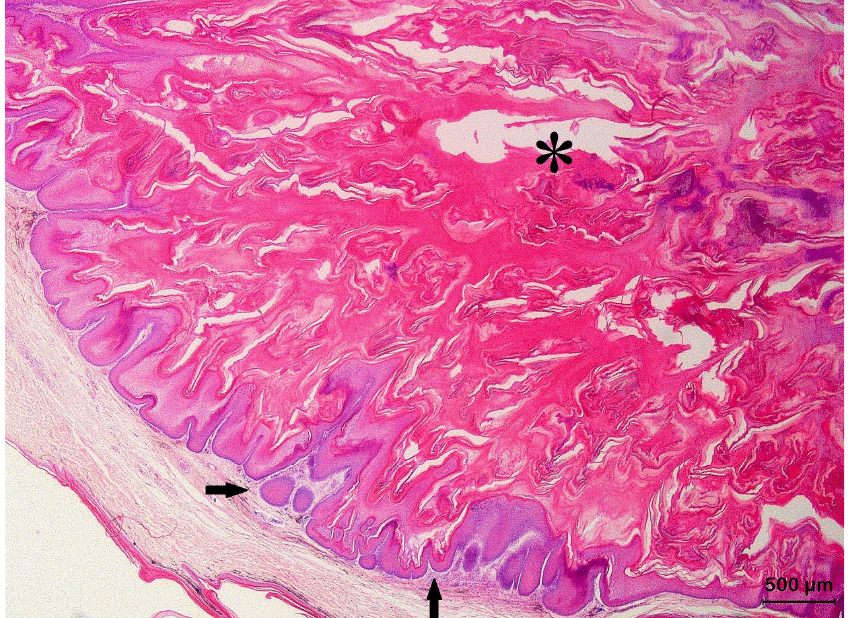
Figure 4. Histological section of a keratoacanthoma from the skin of the body wall of a bearded dragon ( Pogona vitticeps ) showing a characteristic architectural pattern consisting of an exo–endophytic, cyst-like invagination of the epidermis that creates a crateriform lesion with a central keratinous plug (asterisk) and minimally in fi ltrating borders (arrows). BCCs were identi fi ed as malignant proliferations of the skin, the MCJ of the eyelid or the oral mucosa originating from the epidermal basal cells. All BCC histological variants typically contained islands or nests of cuboidal basaloid cells with a central, haphazard, hyperchromatic nuclear arrangement and scant amount of slightly basophilic cytoplasm, resulting in a high nuclear-to-cytoplasm ratio. Keratinization varied according to the his- tological variant. Peripheral palisade formation and stromal cleft formation was consid- ered a rare and inconsistent histological feature. Sporadic areas of necrosis and cystic de- generation were noted. In several cases, ulceration with in fi ltration of in fl ammatory cells from the dermis into the epidermis or subcutis was present. Four distinct histological var- iants could be identi fi ed: solid BCCs (5 cases; 33.3%), keratotic BCCs (5 cases; 33.3%), in- fi ltrating BCCs (4 cases; 26.7%), and basosquamous cell carcinoma (1 case; 6.7%). An over- view of the histological variants and their mitotic index and degree of nuclear atypia are provided in Table 3. Solid BCCs (also referred to as nodular BCCs) were characterized by cords of small polyhedral basaloid cells extending into the dermis that contained small foci of squamous metaplasia (Figure 5). Advanced keratinization with frank extracellular keratin produc- tion resulting in the formation of keratin pearls in the squamoid foci was occasionally seen. The mitotic activity, the number of atypical mitotic fi gures and the degree of nuclear atypia were low, except for one solid BCC that showed high nuclear atypia and moderate mitotic activity.